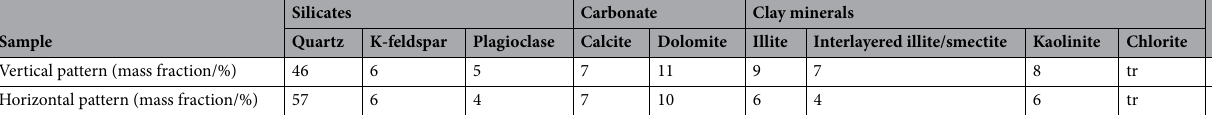
Table 1. XRD analysis of the mass fraction of mineral components in shale samples for vertical and horizontal bedding planes.